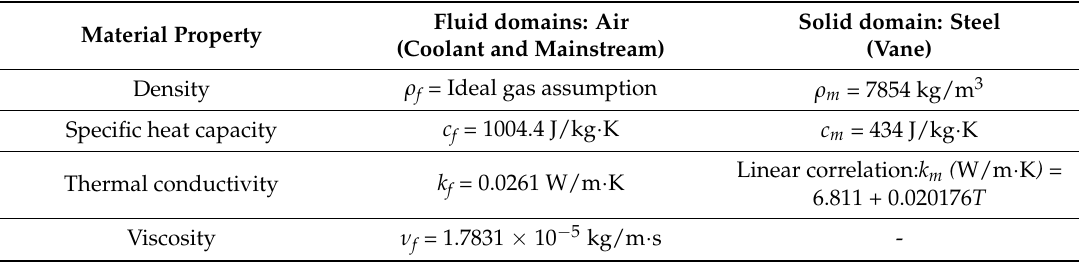
Table 2. Material properties.